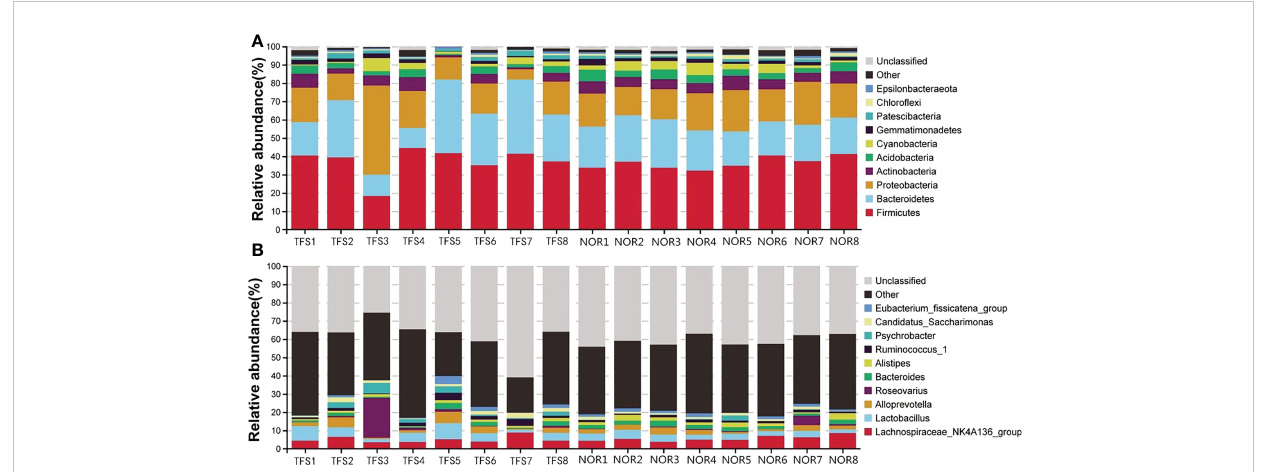
FIGURE 3 Taxonomy stack distributions of different levels of classi fi cation for normal (NOR) and TFS D. hystrix . The top 10 phylum (A) and genus (B) were selected, and the rest were uni fi ed to the other